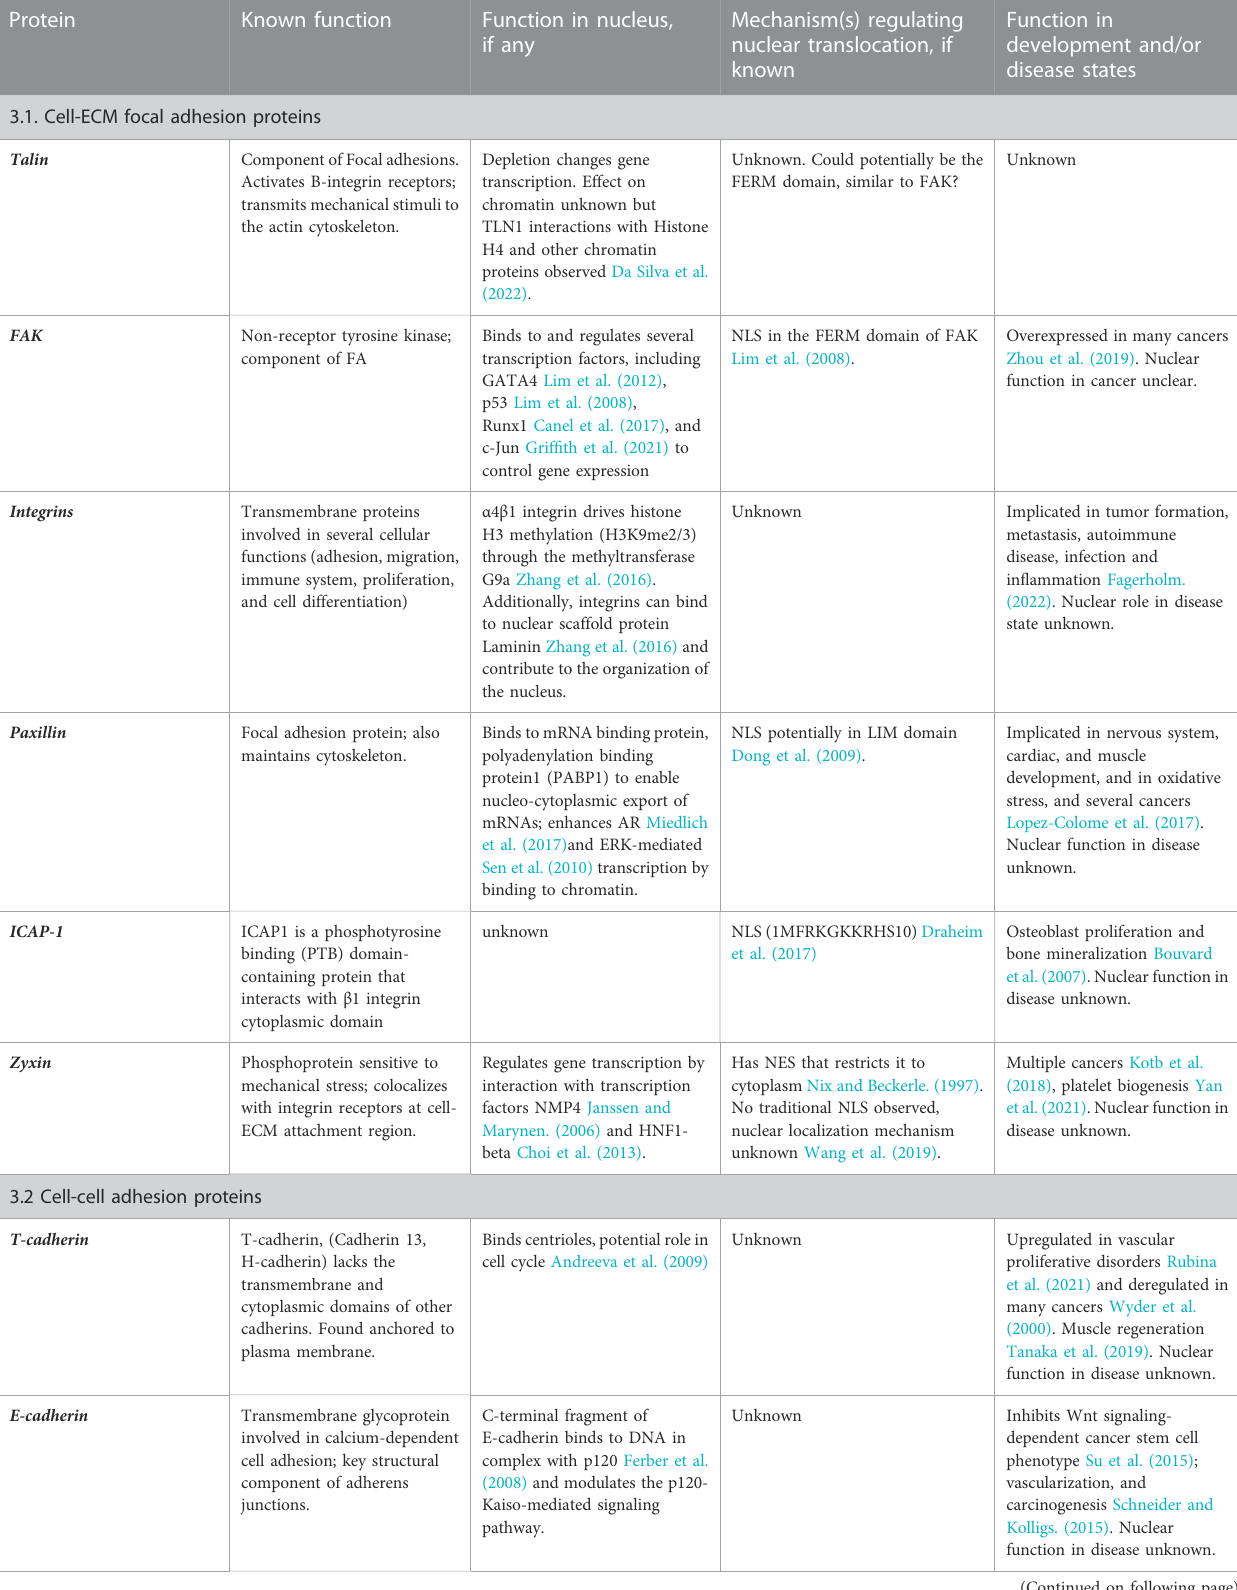
TABLE 1 Summary of Cell adhesion proteins and their function in the nucleus.